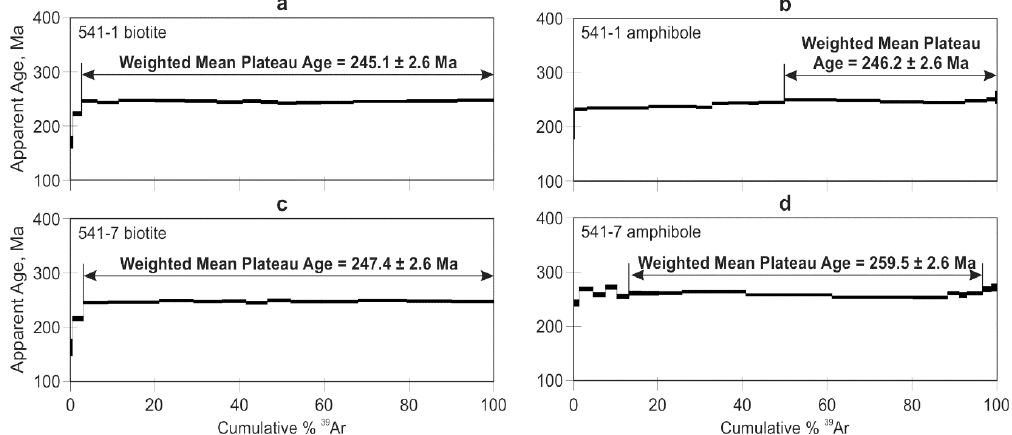
Figure 16. Ar-Ar age spectra for biotite and amphibole from diorite sample 541-1 ( a , b ) and diorite sample 541-7 ( с , d ).